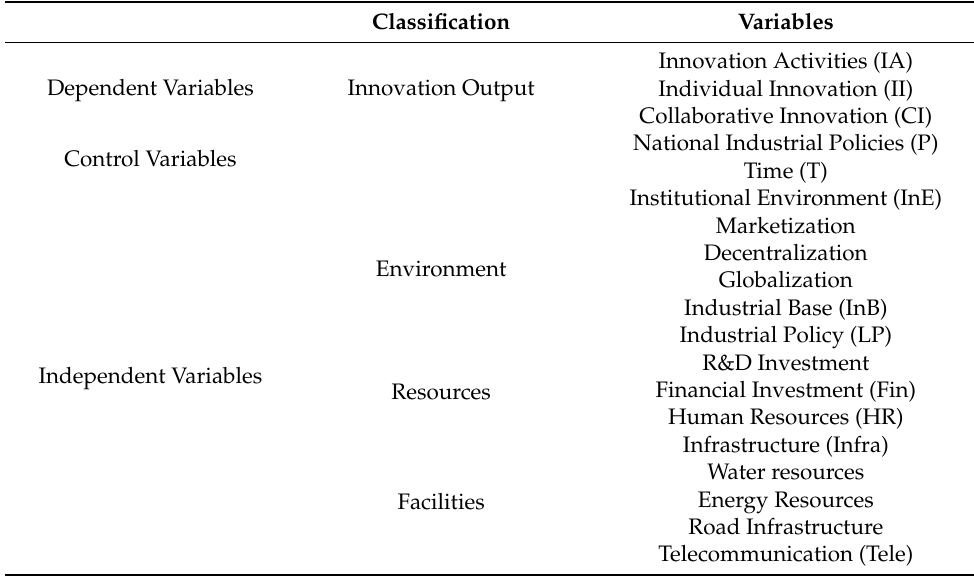
Table 1. The indicators of innovation activities and innovation